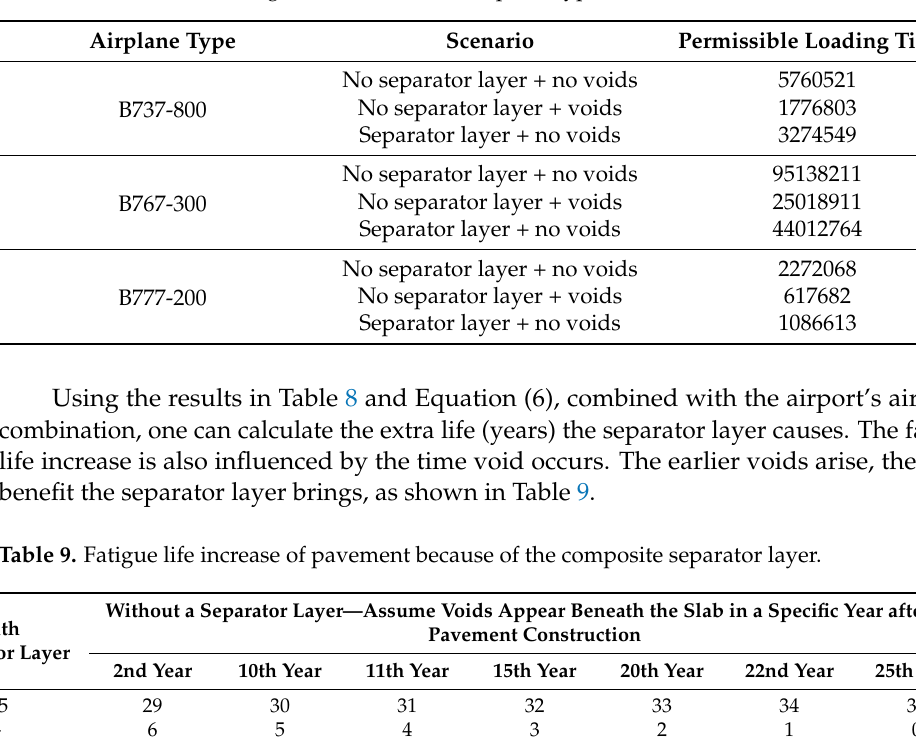
Table 8. Permissible loading times for different airplane types under different scenarios.